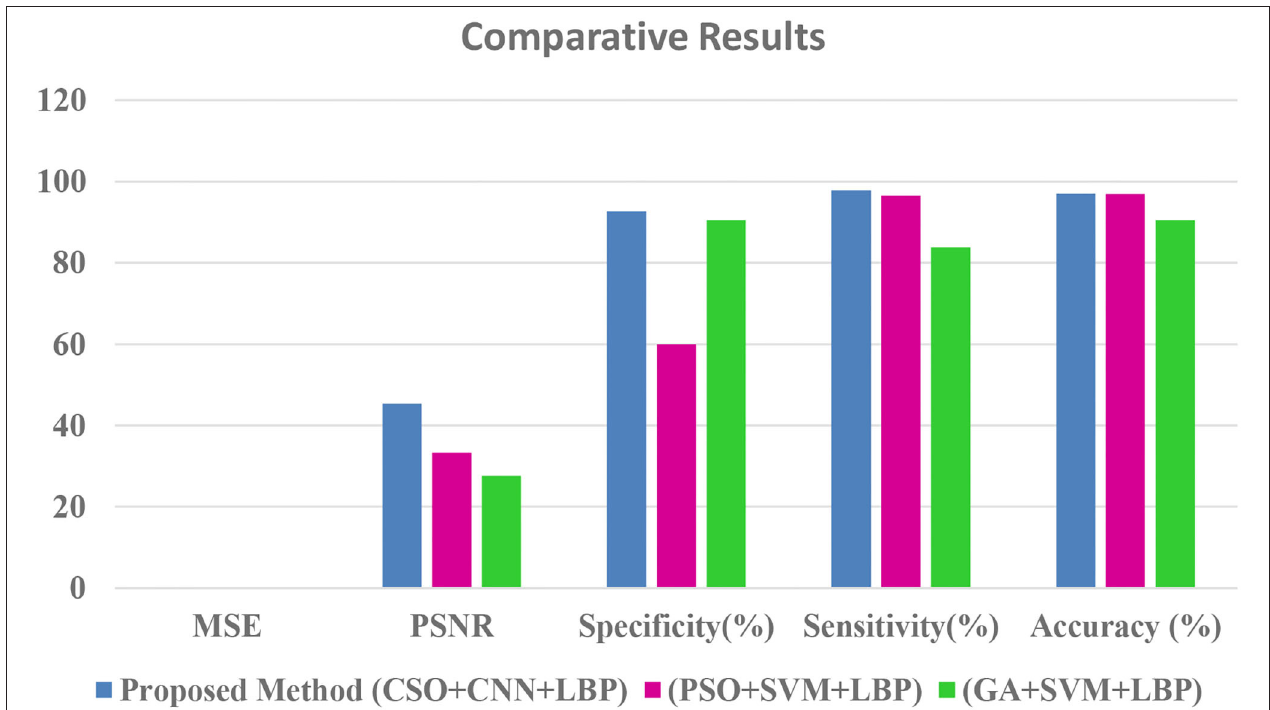
FIGURE 8 | Comparative results graphical